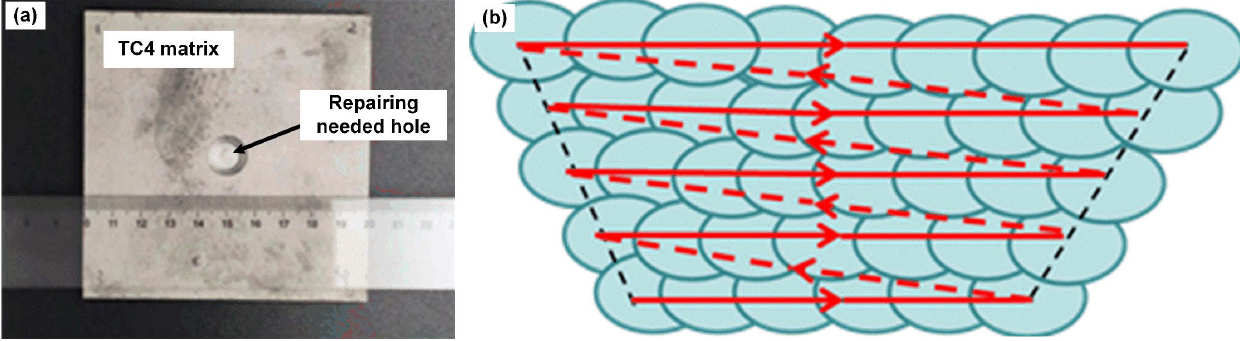
Table 2. Detailed process parameters employed in this research.